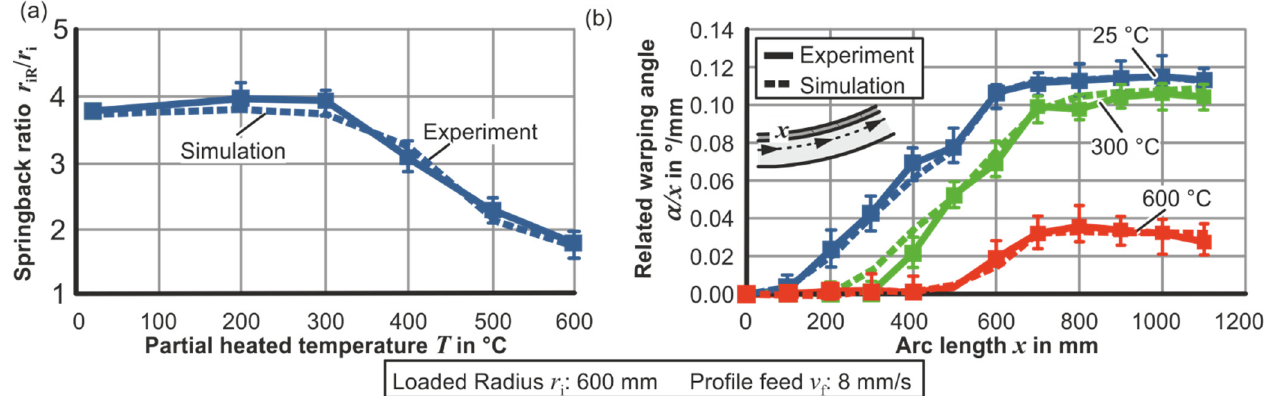
Figure 10. Comparison of springback ( a ) and related warping angle ( b ) between experiments and Simulation for 8 mm/s feed and loaded radius of 600 mm.